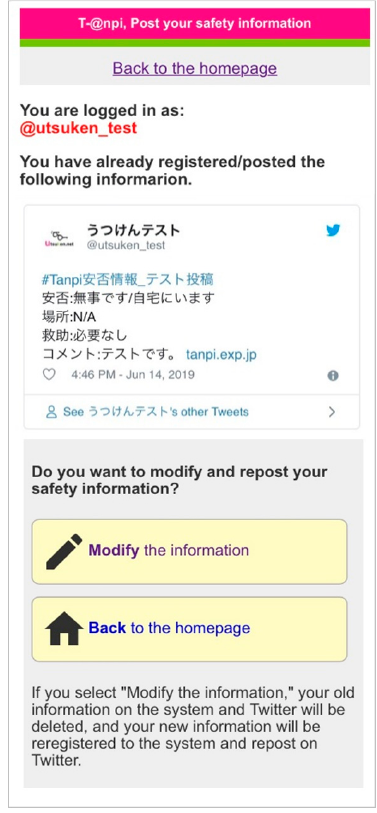
Figure 9. Page that requests whether the sending user wishes to reregister the safety information.